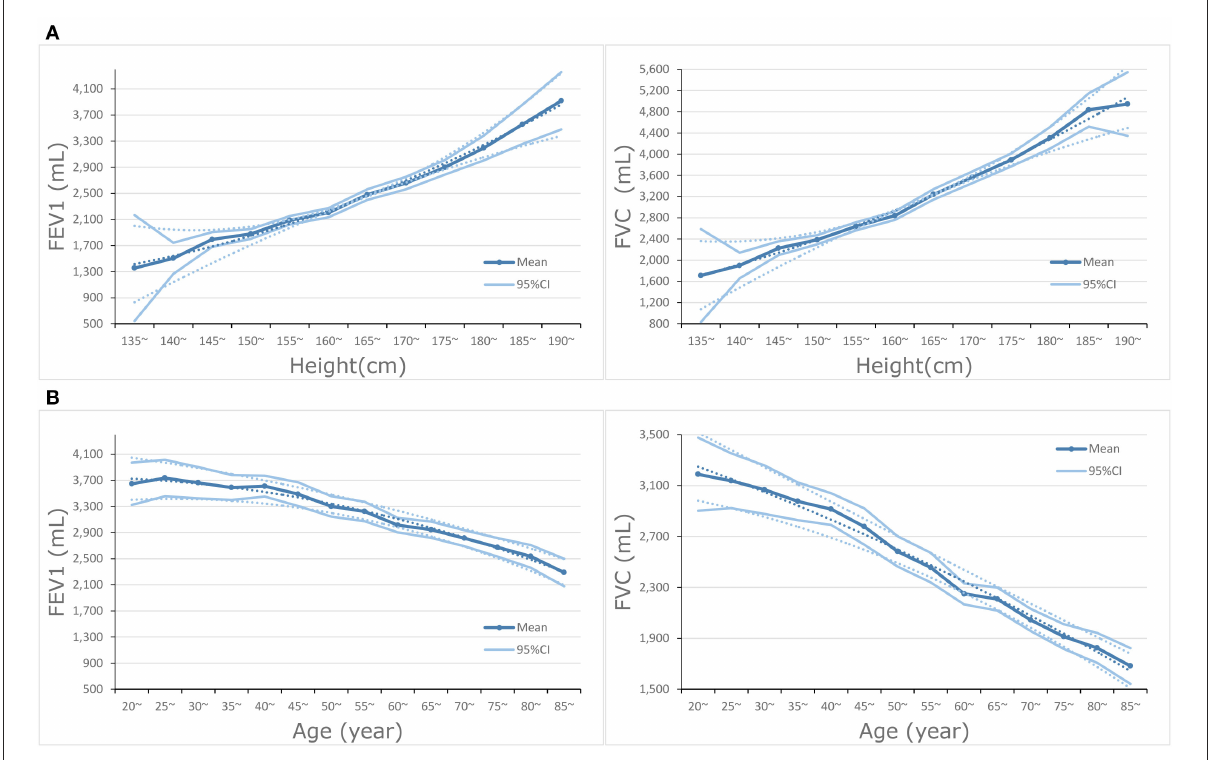
FIGURE2 (A) Dose-response association between height and FEV1 and FVC. (B) Dose-response association between age and FEV1 and